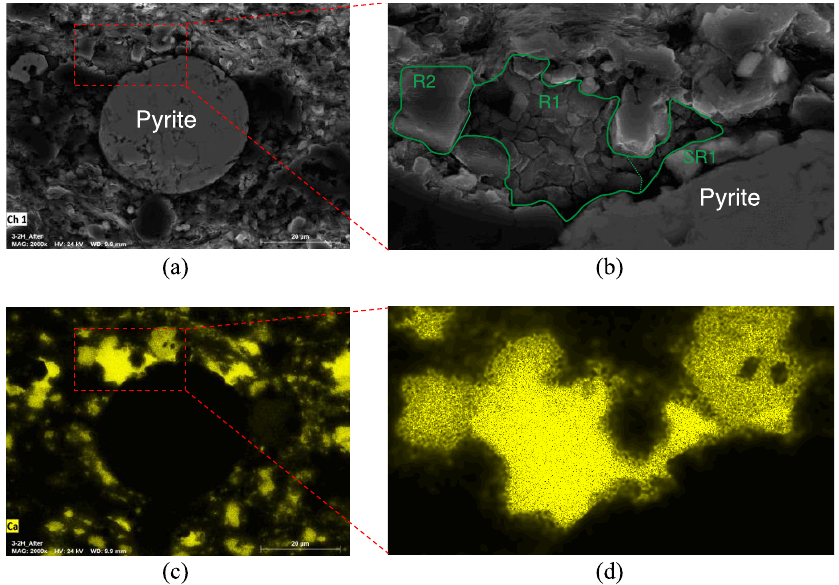
Figure 15. BSE images and EDS maps for a region with carbonate minerals; ( a , b ) BSE images of a region with calcite and dolomite alteration; ( c , d ) calcium EDS maps of the same region.